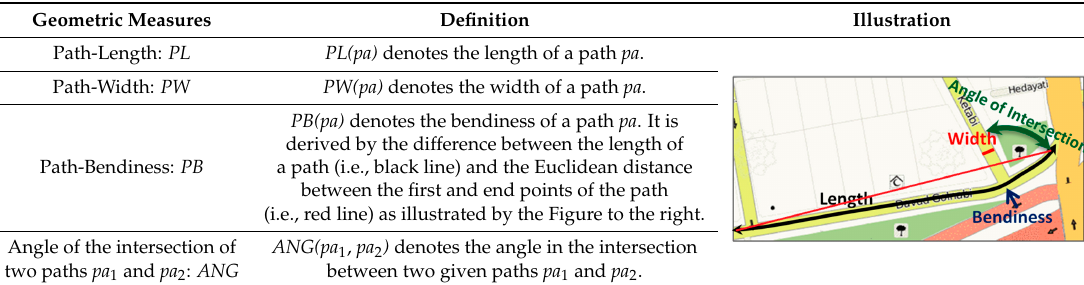
Table 4 . Geometric measures applied to urban paths.